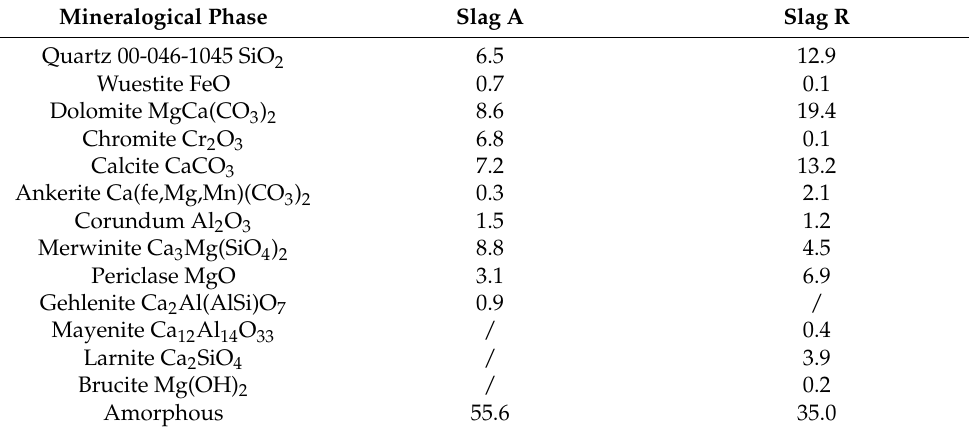
Table 2. Quantitative mineralogical analyses of Slag A and Slag R (all in wt.%). Rietveld refinement was performed by X’Pert High Score Plus diffraction software with goodness of fit of